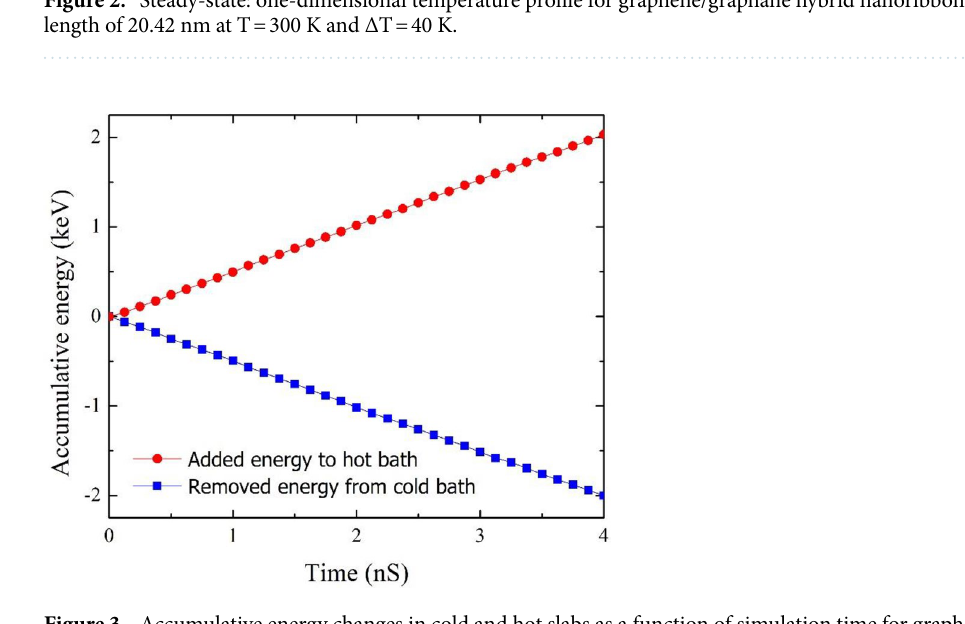
Figure 3. Accumulative energy changes in cold and hot slabs as a function of simulation time for graphene/ graphane hybrid nanoribbon with a length of 20.42 nm at T = 300 K and ΔT = 40